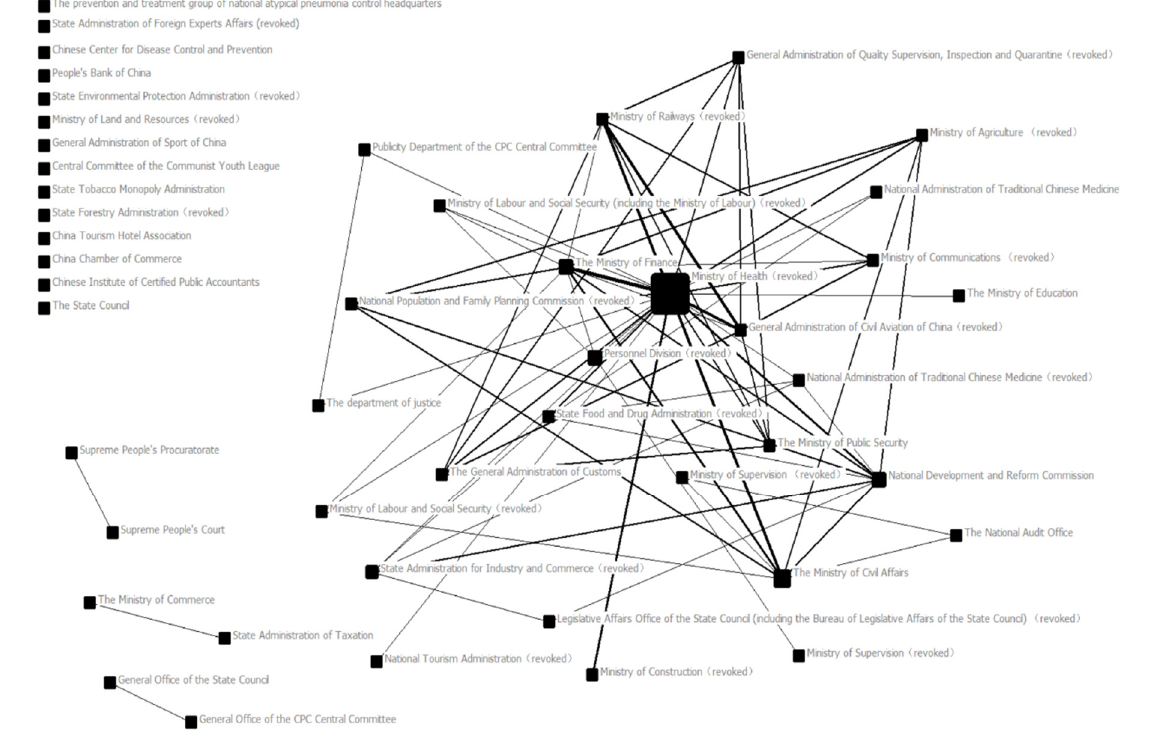
Figure 1. Inter-agency cooperation network for public policy making during SARS.